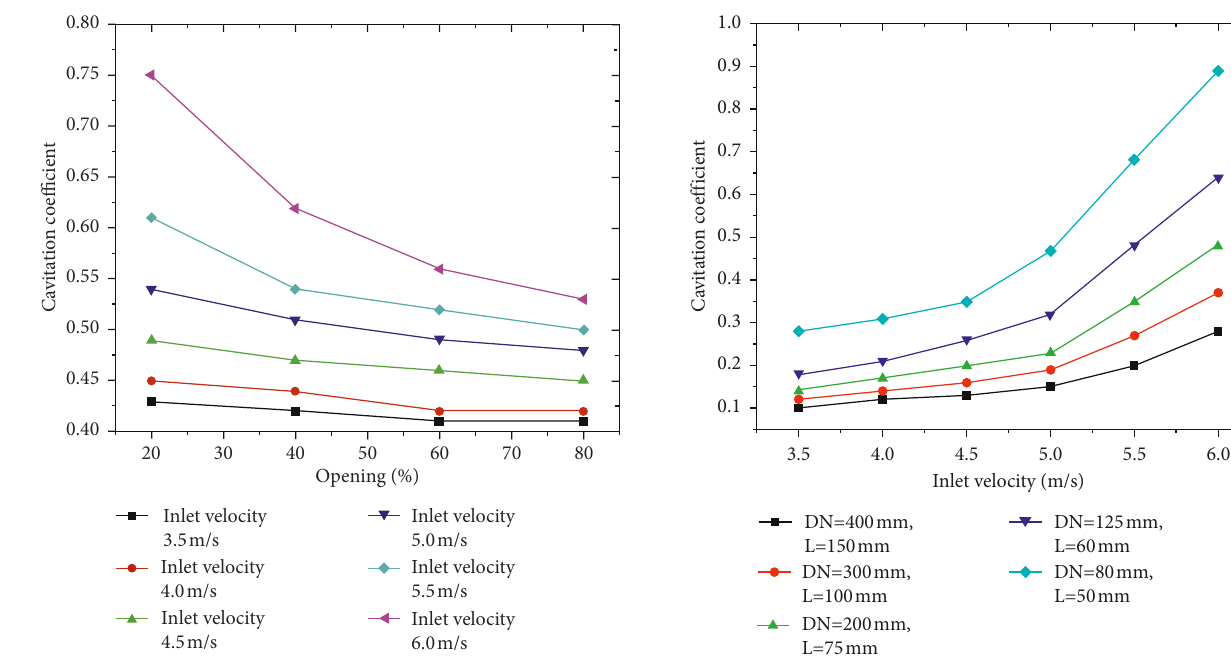
Figure 46: Variation of inlet velocity and cavitation coefficient with nominal diameter at full opening.